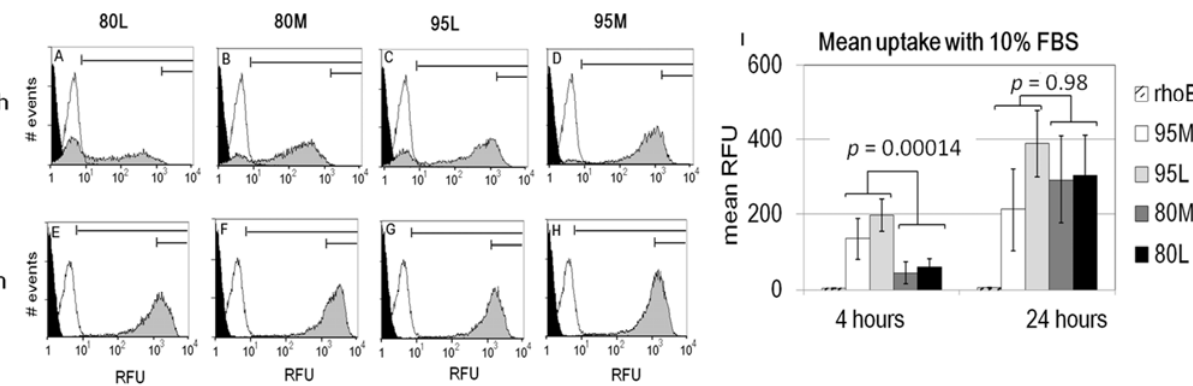
Figure 7. Flow cytometry analysis of rhodamine B and RITC-chitosan uptake after 4 h ( A – D ) or 24 h ( E – H ) of culture in 10% FBS, for 4 structurally distinct chitosans (as indicated), and mean RFU values from N = 3 to 5 distinct experiments ( I ). For A – H : Black peak: unlabeled cells; white peak: rhoB-labeled; grey peak: RITC-chitosan-labeled.